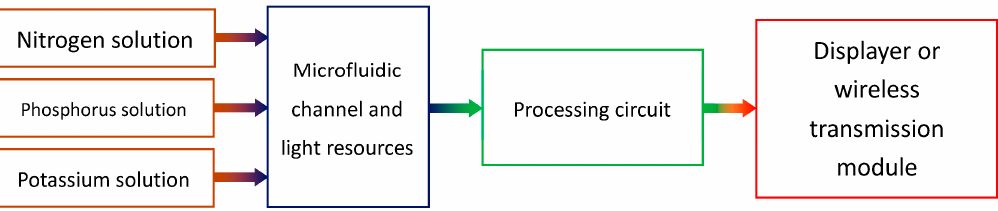
Figure 1. Colorimeter system components.